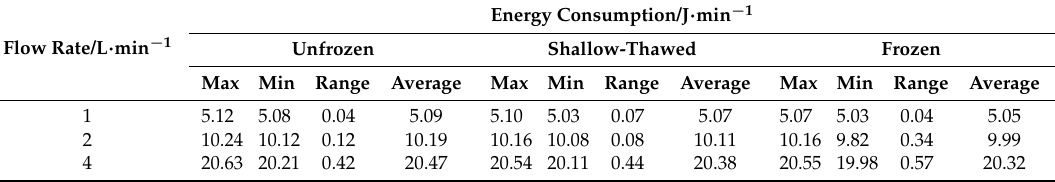
Table 3. The statistics of energy consumption over unfrozen, shallow ‐ thawed, and frozen slopes at different flow rates.